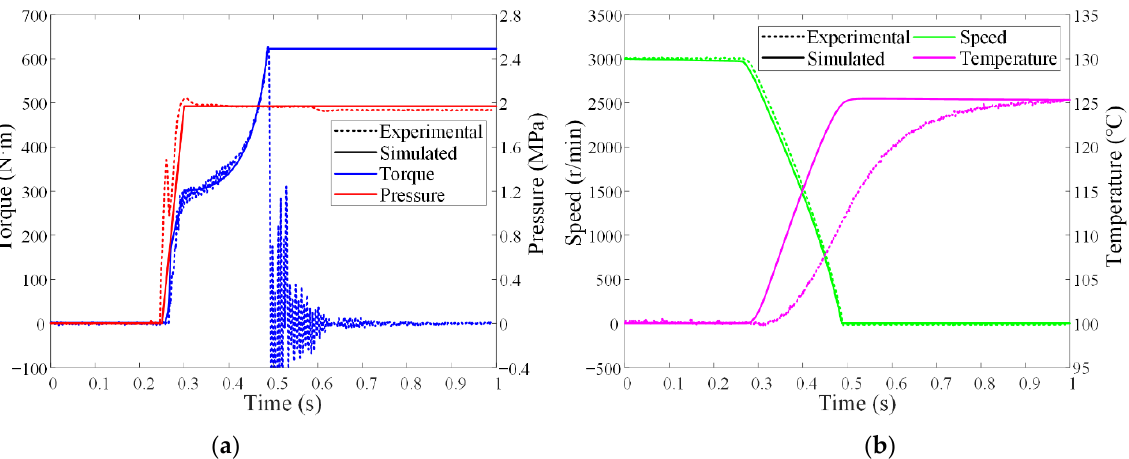
Figure 5. Verifications of simulation data. ( a ) Torque and pressure. ( b ) Speed and